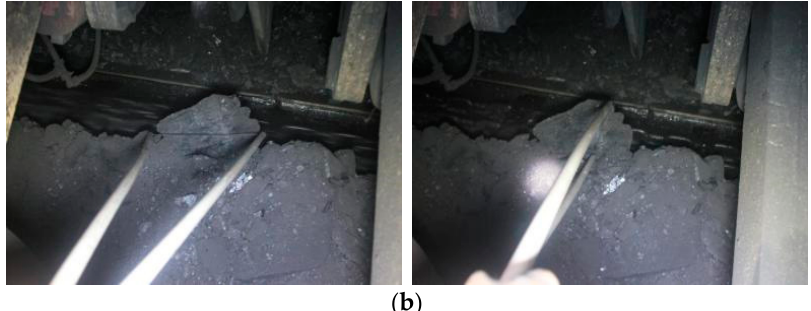
Figure 12. The caving block size measuring of top coal before and after hydraulic fracturing: ( a ) before hydraulic fracturing and ( b ) after hydraulic fracturing.